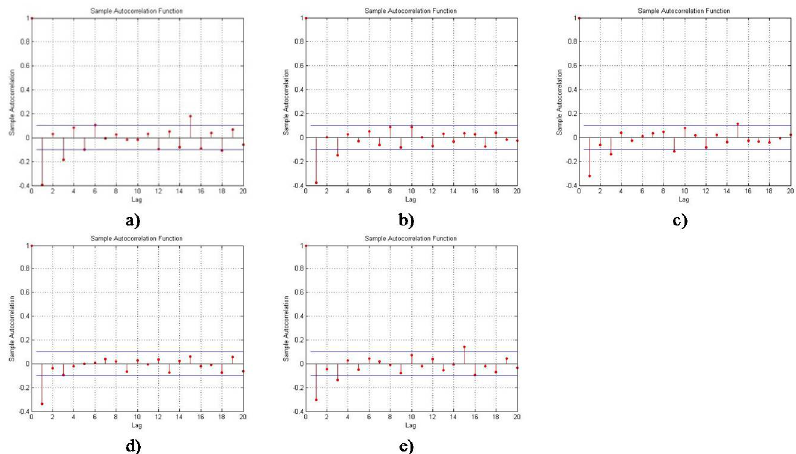
Figure 4. Autocorrelation function for: ( a ) three fuzzy states; ( b ) four fuzzy states; ( c ) five fuzzy states; ( d ) six fuzzy states; ( e ) seven fuzzy states.